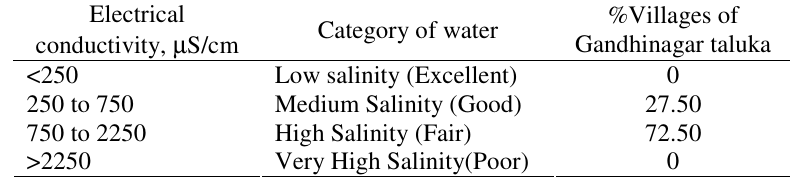
Table 10. Classification of water quality of Gandhinagar taluka for irrigation purpose (According to the classification made by United State Salinity